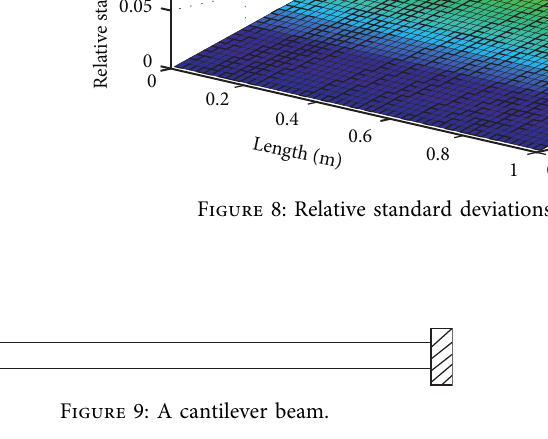
Figure 9: A cantilever beam.